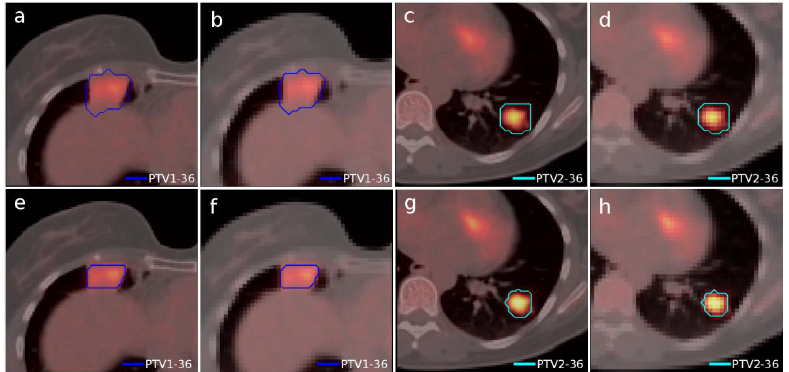
Figure 4. Segmented structures as targets in Case 3 using accreditations from EARL1 (top) and EARL2 (bottom). Contours in an isocenter axial slice of PTV1 and PTV2 in the PET/CT grid ( a , c , e , g ) and in the dose calculation grid ( b , d , f , h ). The color scale is the same for all figures.